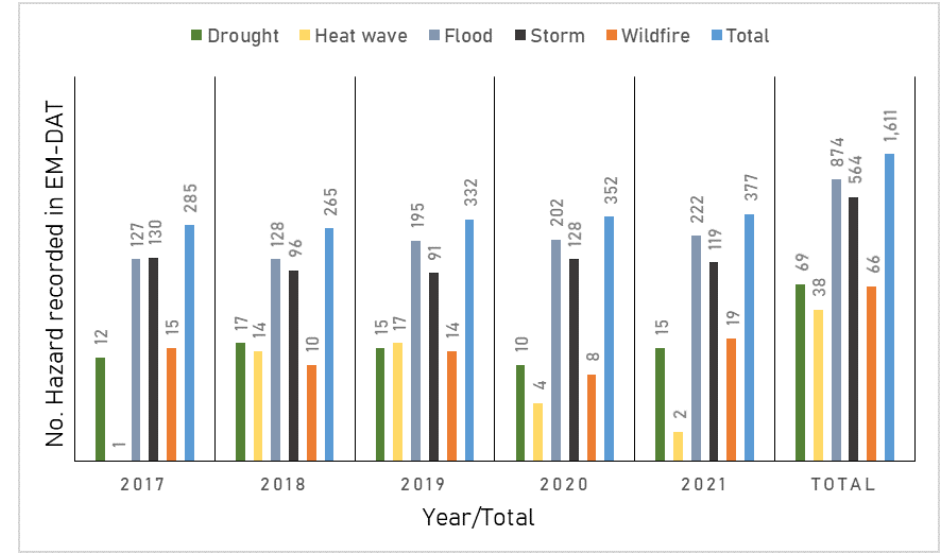
Figure 1. The total number of disasters reported per weather hazard for the last 5 years, as reported in EM-DAT (CRED, 2020).